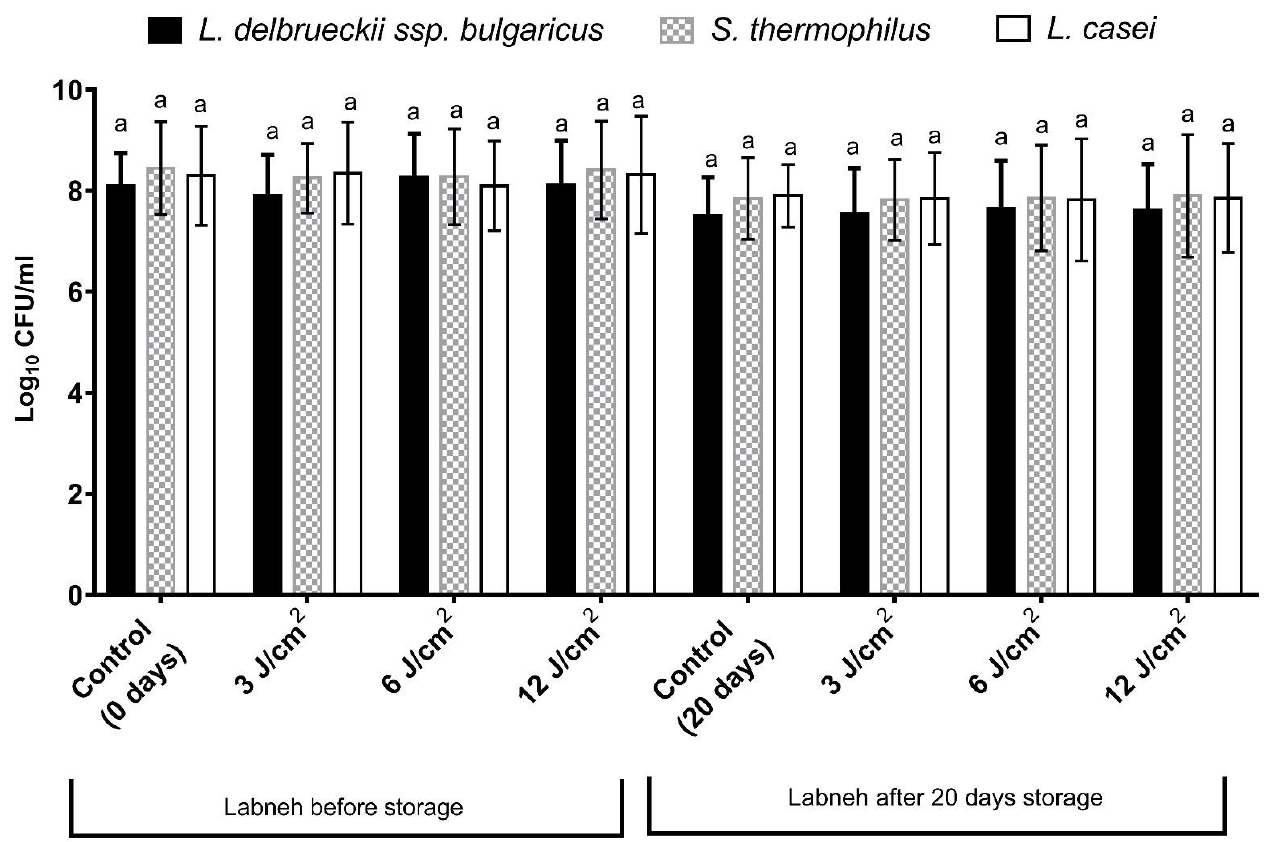
Figure 3. Changes in the viable counts (Log 10 CFU/g) of the starter cultures of different labneh treatments before and after 20 days of cold storage. The bars on the graph represent the mean ± SD as a Log 10 CFU/g of triplicate independent experiments ( n = 3). The common letters above the bars are not significantly different ( p < 0.05) within the same bacterial species.